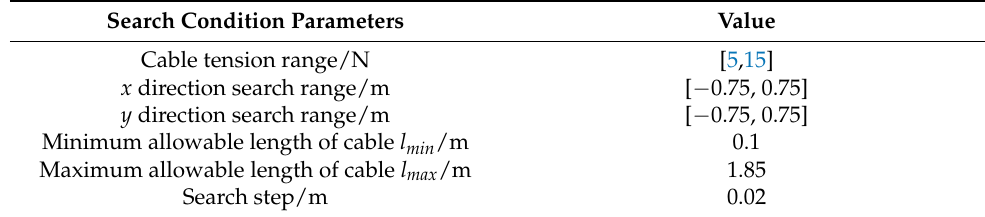
Table 1. Workspace search condition parameters.